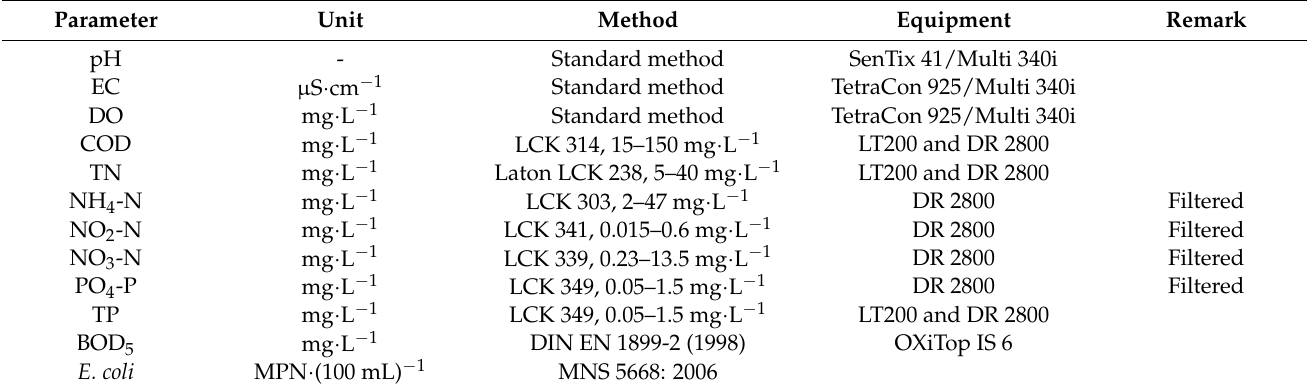
Table 1. Overview of water quality parameters and analytical